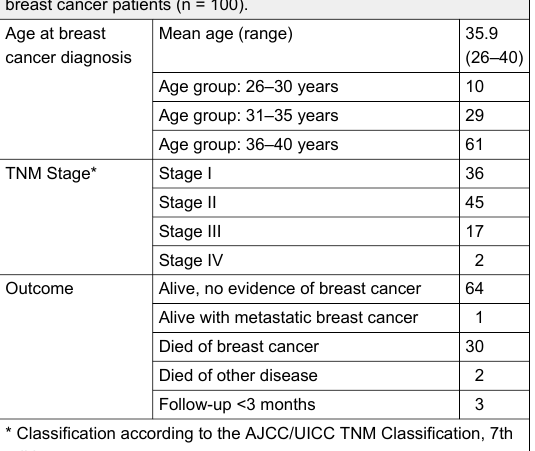
Table 1: Age, disease stage and outcome characteristics of young breast cancer patients (n = 100).